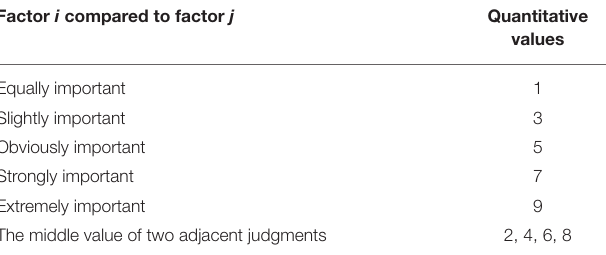
TABLE 2 | Scale method for the elements. Factor i compared to factor j Quantitative